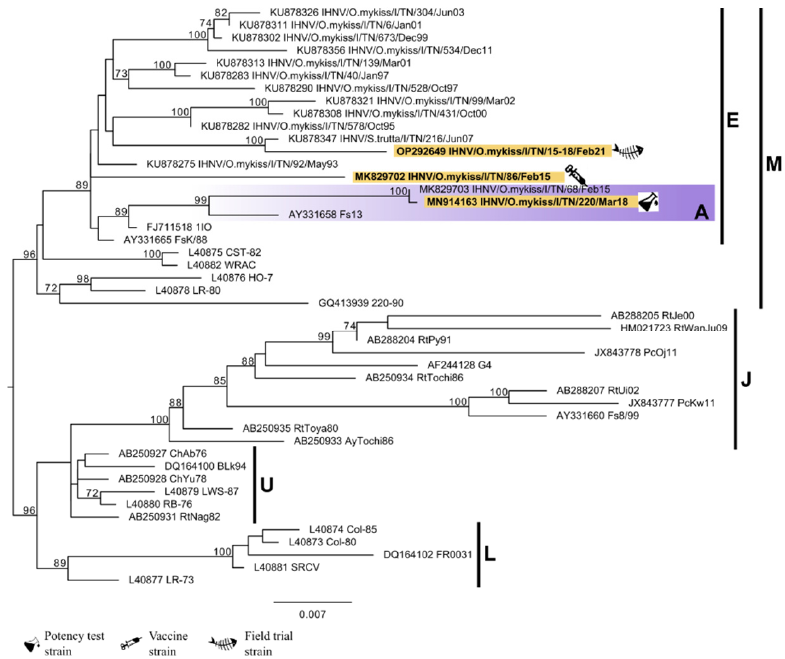
Figure 3 . Phylogenetic tree based on the complete G gene sequence of IHNV. The strain used for the plasmid production, the strain used for the potency test, and the strain isolated during the field trial are highlighted in yellow. Vertical lines indicate the division into different genogroups and sub-lineages. The colored box highlights the genetic cluster identified within sub-lineage E [19,27]. Posterior probability values ≥ 70 are shown for each node. The scale bar indicates the number of substitutions per site.